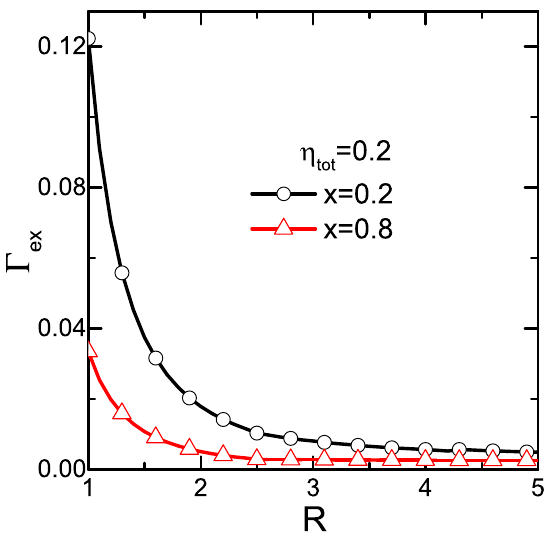
Figure 4. Excess adsorption Γ ex of the binary mixture confined by a SPM. Note that the symbols in the figure is used to guide